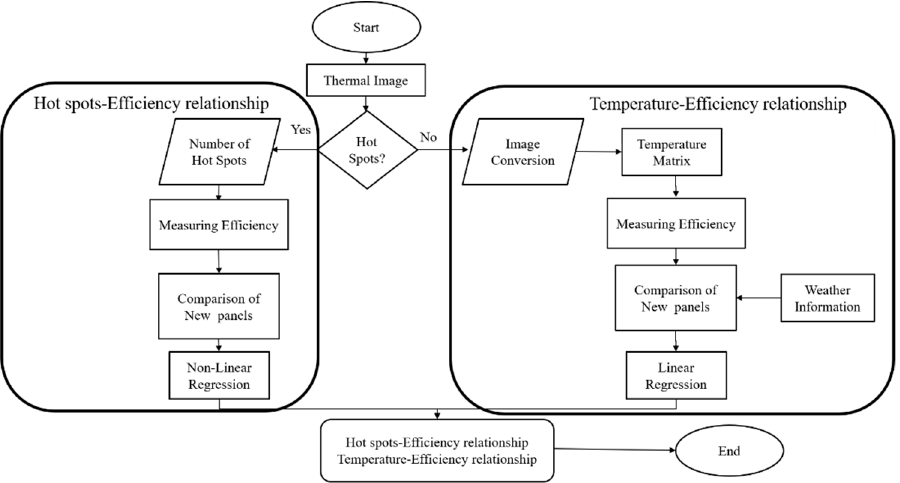
Figure 1. Proposed process of analyzing the relationships among the number of hotspots, temperature and efficiency.